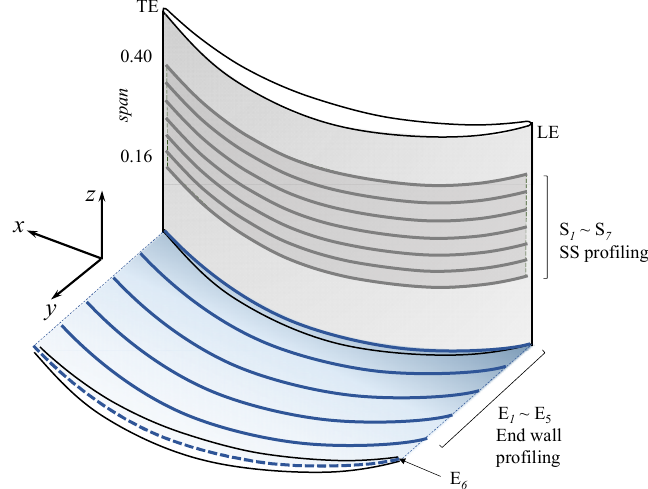
Figure 2. Parameterization of the SS profiling and end wall profiling.